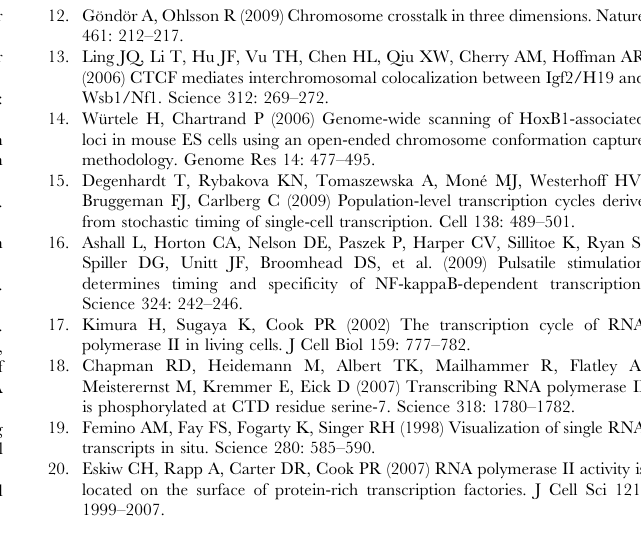
Figure S7 Selected 3C interactions assessed by quanti- tative real-time PCR. HUVECs were treated with TNF a for 0–30 min, 3C templates prepared using Sac I, and qPCR conducted using equal weights of DNA and primers targeting indicated regions; amounts of 3C products detected were normalized relative to intra- GAPDH 3C amplimers (as in [27]). In some cases DRB was added 20 min before harvesting cells. Cartoons illustrate where polymerases are bound at different times and the interactions analyzed (grey lines); red lines indicate interactions detected, and these correlate with the presence of a polymerase on both partners. Values are averages ( 6 standard deviation) from three independent experiments. (A) Interactions between SAMD4A fragment c and four TNF a -responsive genes. Strong interactions are seen with three genes (but not NFKBIA ). (B) Interactions between SAMD4A fragments b–d and TNFAIP2 . Strong interactions are seen at appropriate times, confirming results in Figure 3. As DRB inhibits productive elongation (see Figure S6), interactions around the promoter and tss are still detected. Figure S8 Using Hind III to prepare 3C templates yields interactions like those seen with Sac I. Details are as for Figures 3 and 4; essentially the same changing patterns are detected. (A) Positions of 3C primers. (B) Interactions between SAMD4A and TNFAIP2 . (C) Interactions between SAMD4A and the tss of SLC6A5 . Figure S9 Some 3C controls. (A) Specificity of inter- genic interactions. Genes screened (TNF a -responsive, non- responsive, and constitutive) are indicated on the map of part